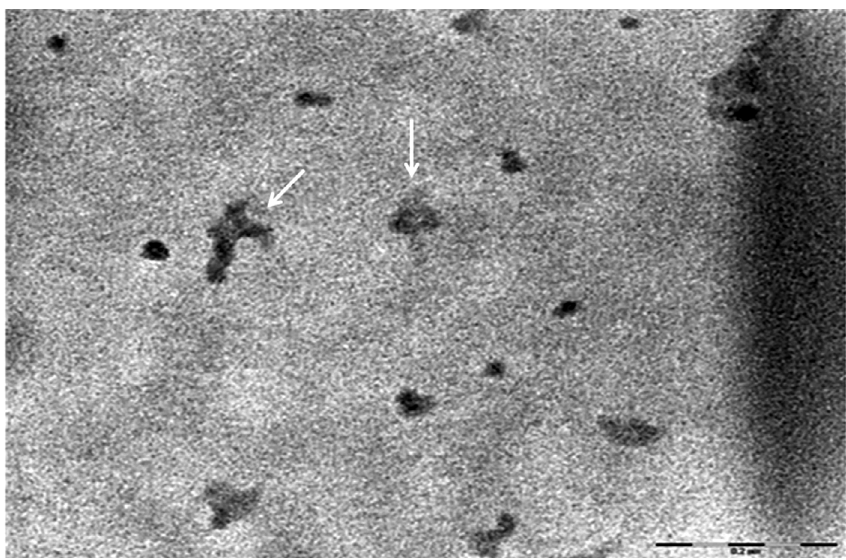
Figure 1- Transmission electron photomicrography of chitosan nanoparticles formation showing dispersed spherical nanoparticles and small areas of aggregation (↓). Reference bar=0.2